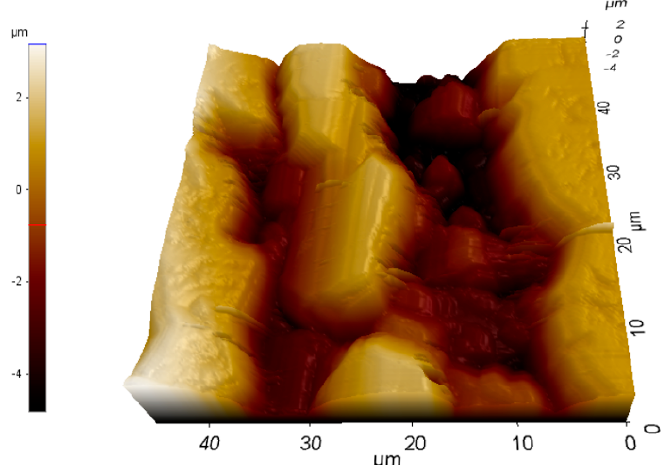
Figure 3. AFM (atomic force microscope) images of surface three-dimensional topography of the striped PSS.